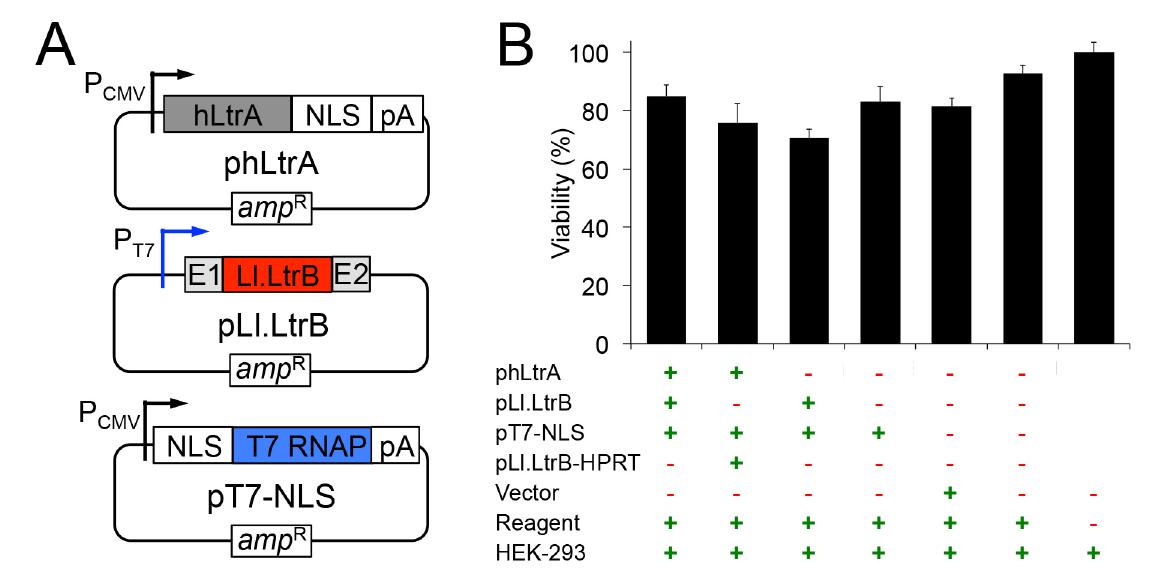
Fig 1. Plasmids used for expressing the mobile Ll.LtrB group II intron in human cells and their effect on cell viability. (A) Mobile group II intron expression plasmids. phLtrA uses a CMV promoter to express a humanized LtrA protein (hLtrA) with a C-terminal SV40 NLS followed by a human growth hormone polyadenylation signal (pA). pLl.LtrB uses a minimal T7 promoter to express the Ll.LtrB- Δ ORF intron with flanking 5 ’ and 3 ’ ltrB exons (E1 and E2, respectively). pT7-NLS uses a CMV promoter to express T7 RNAP with an N-terminal SV40 NLS followed by the same polyadenylation signal as above. (B) Cytotoxicity assays. HEK-293 cells were transfected with the indicated plasmids. After 48 h in culture, luciferase activity was measured as an indicator of total cellular ATP content and cell viability by using a CellTiter-Glo direct lysis kit. Plasmid pLl.LtrB-HPRT expresses an Ll.LtrB intron targeted to the mouse hprt gene [45], the vector is pBluescript and the reagent is Lipofectamine 2000. The bar graph shows the average for three separate transfections with the error bars indicating the SEM.